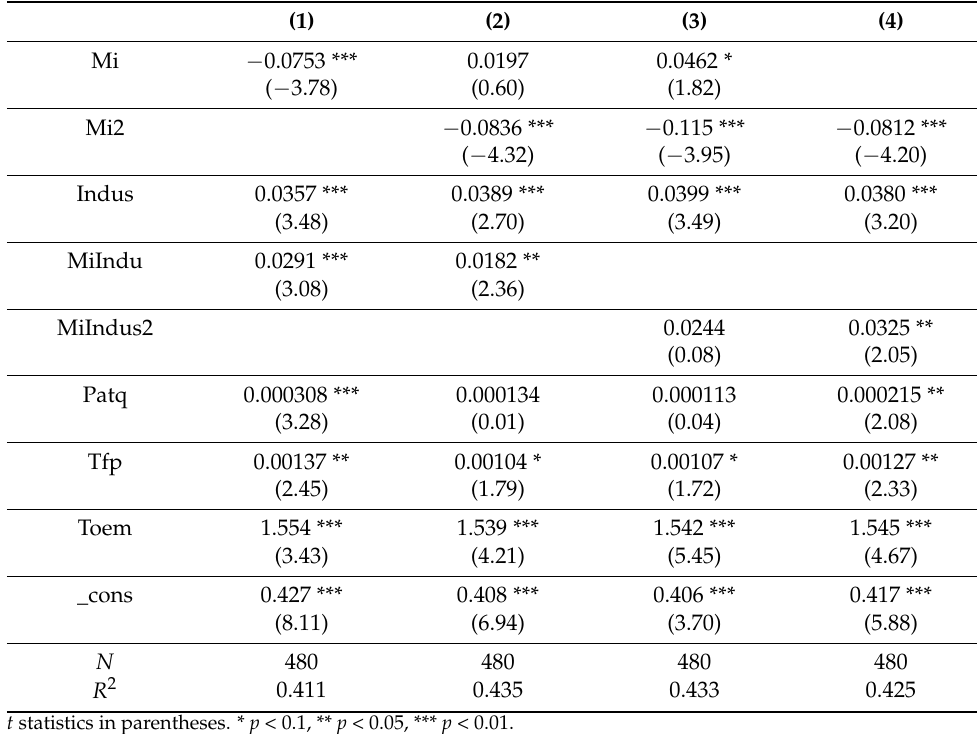
Table 5. Path-dependent reinforcement effect results.